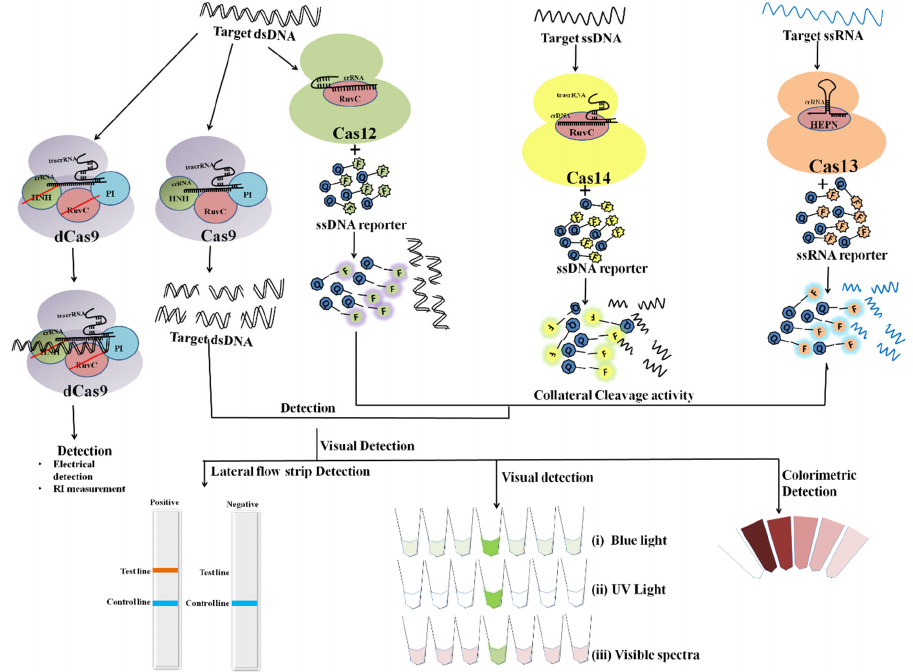
Figure 5. Overview of different CRISPR/Cas effector mechanisms with various result interpretation strategies.